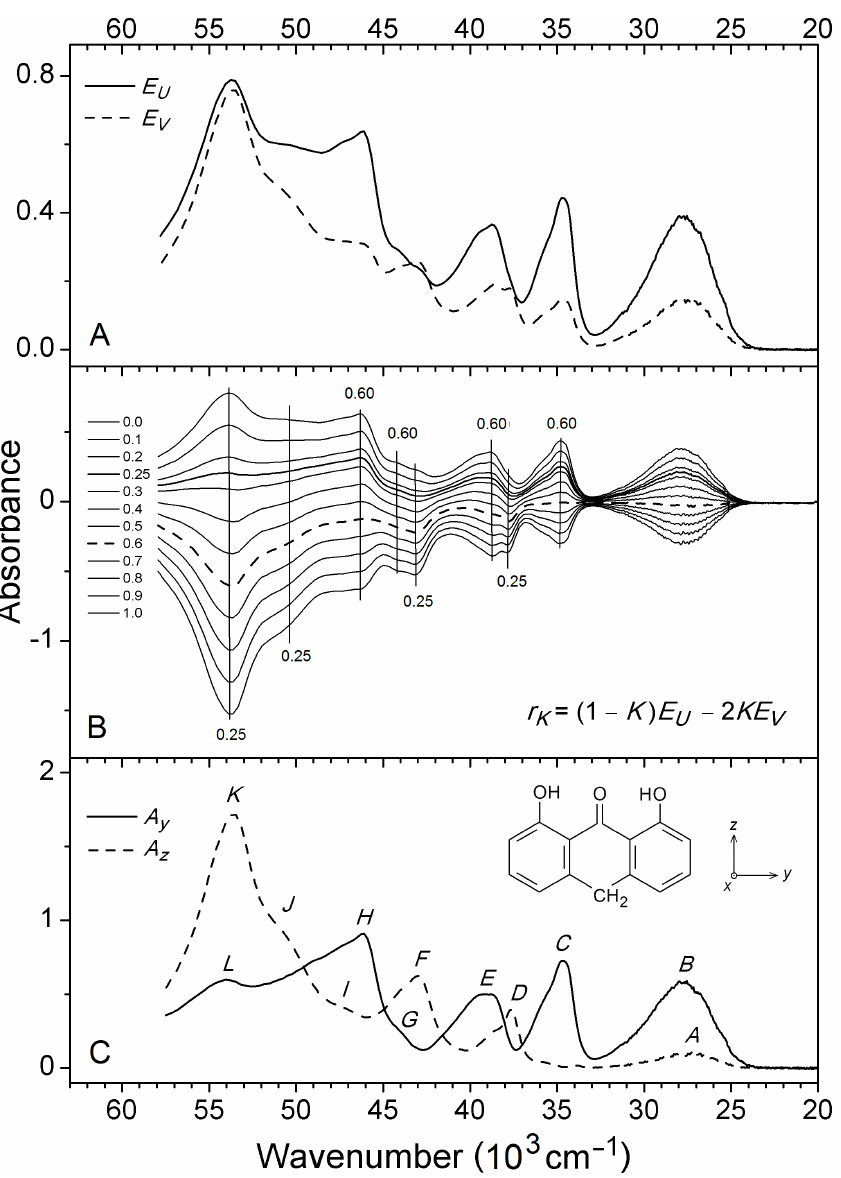
Figure 2 Observed SRLD absorbance curves. (A) Absorbance curves E U and E V for anthralin ( A ) par- tially aligned in uniaxially stretched polyethylene, indicating absorbance measured with linearly polar- ized radiation with electric vector parallel and perpendicular, respectively, to the stretching direction U of the polymer. (B) Family of reduced absorbance curves r K according to Eq. (2) with K varying from 0.0 to 1.0 in steps of 0.1. Orientation factors K determined for prominent features are indicated. (C) Partial ab- sorbance curves A y and A z according to Eq. (3) corresponding to absorbance polarized along the molecu- lar axes y and z , see